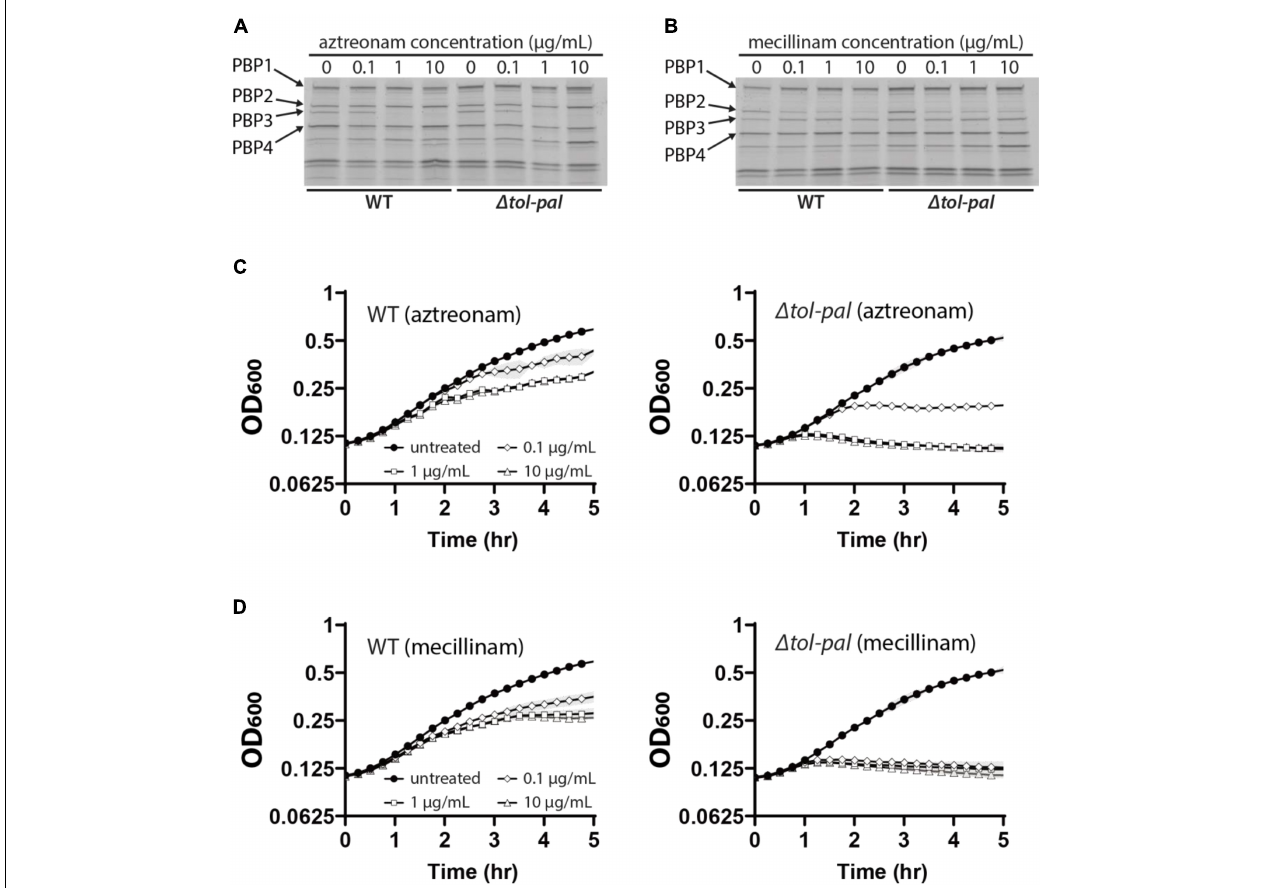
FIGURE 3 | OM permeability defects do not account for the accelerated lysis of the tol-pal mutant. (A,B) Bocillin assay to compare the binding specificity of aztreonam and mecillinam to PBPs between the wild type and (cid:49) tol-pal strains. Cultures of MG1655 and SP23 ( (cid:49) tol-pal ) strains were grown to the exponential phase (OD 600 = 0.5) in LB at 30 ◦ C and treated with the indicated concentrations of aztreonam (A) or mecillinam (B) for 5 min. Cells harvested from 15 ml of each culture were labeled with Bocillin. Bocillin-labeled PBPs of each sample were separated on 4–20% SDS-PAGE gels and visualized by fluorescence scanning. (C,D) Lysis curves of MG1655 and SP23 strains after treatment of the cultures with the indicated concentrations of aztreonam (C) or mecillinam (D) . MG1655 and SP23 cells were grown to the exponential phase (OD 600 between 0.2 and 0.3) as described for Figure 1 , and diluted to an OD 600 of 0.1 in LB supplemented with the indicated final concentrations of aztreonam (C) or mecillinam (D) . The optical density of the cultures was measured in the same way as in Figure 1